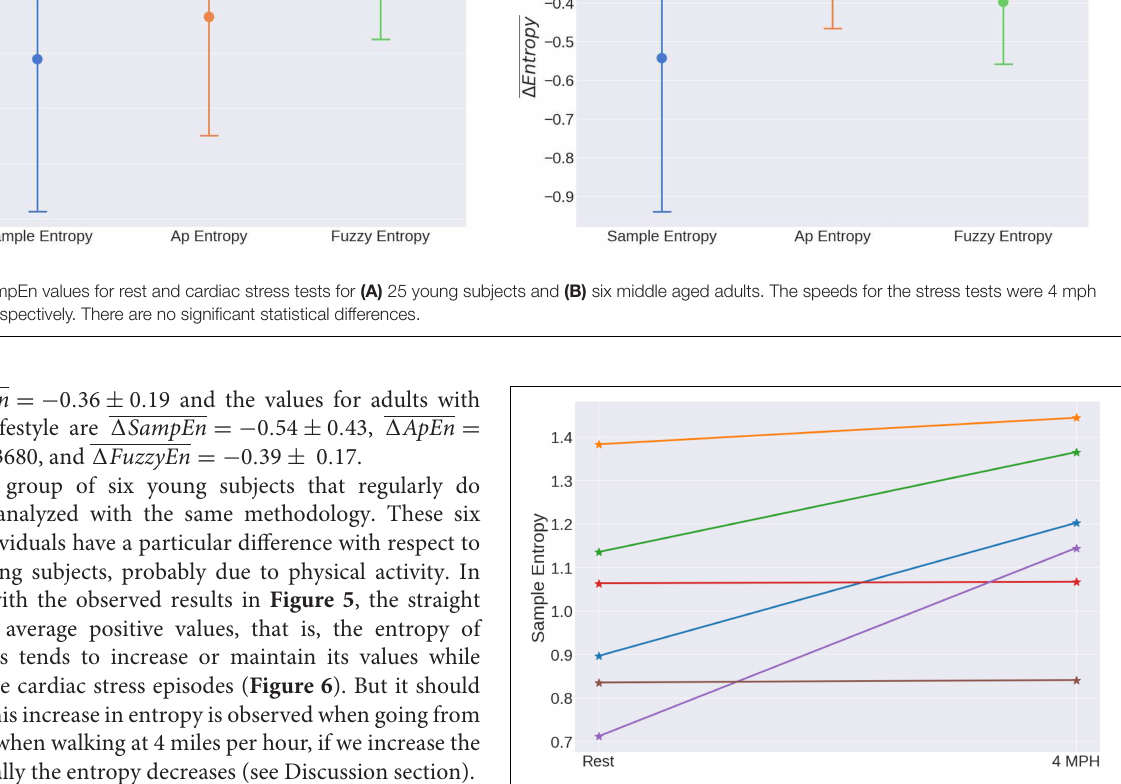
FIGURE 6 | Sample entropy values for rest and cardiac stress tests for six young subjects that do regular physical activity.